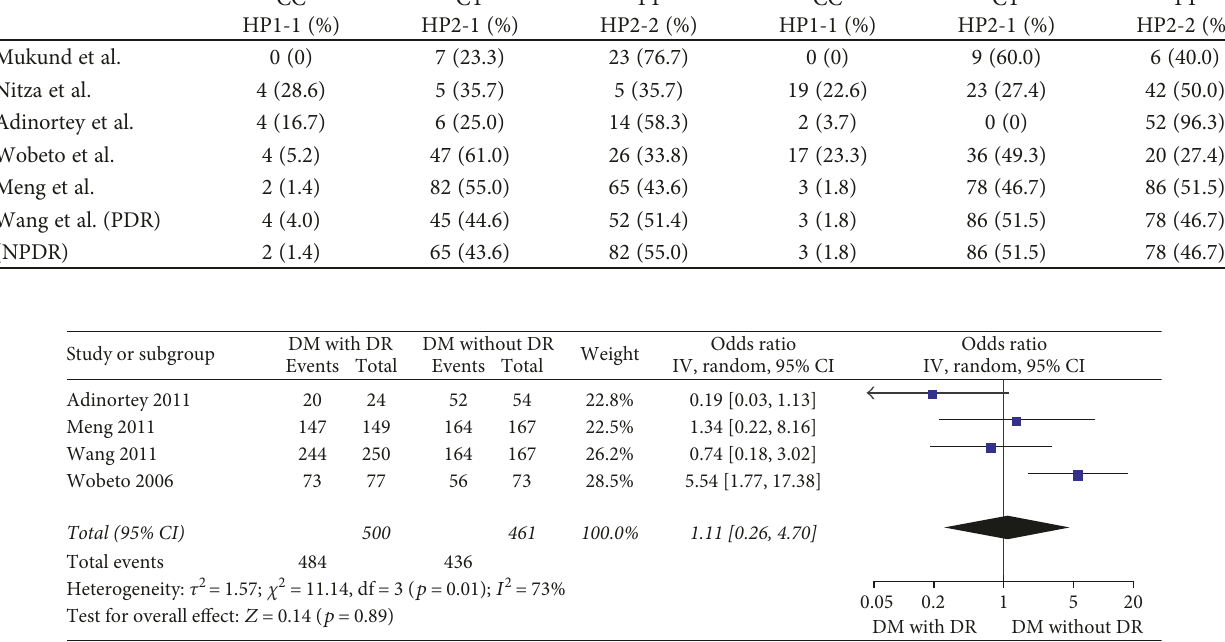
Figure 2: Forest plot for meta analysis comparing DR with DWR in dominant model (TT +CT versus